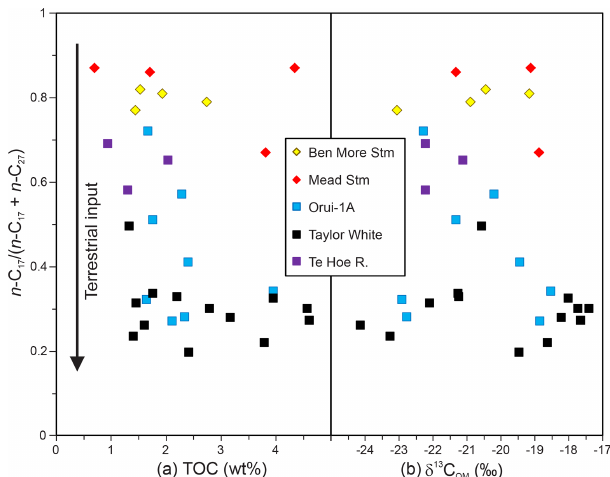
Figure 16. Relative abundance of C 17 n -alkanes in relation to (a) TOC and (b) δ 13 C OM as a guide to aquatic/marine input in Waipawa organofacies at five sections representing a middle shelf to middle slope transect: Te Hoe River → Taylor White → Orui- 1A → Mead Stream → Ben More